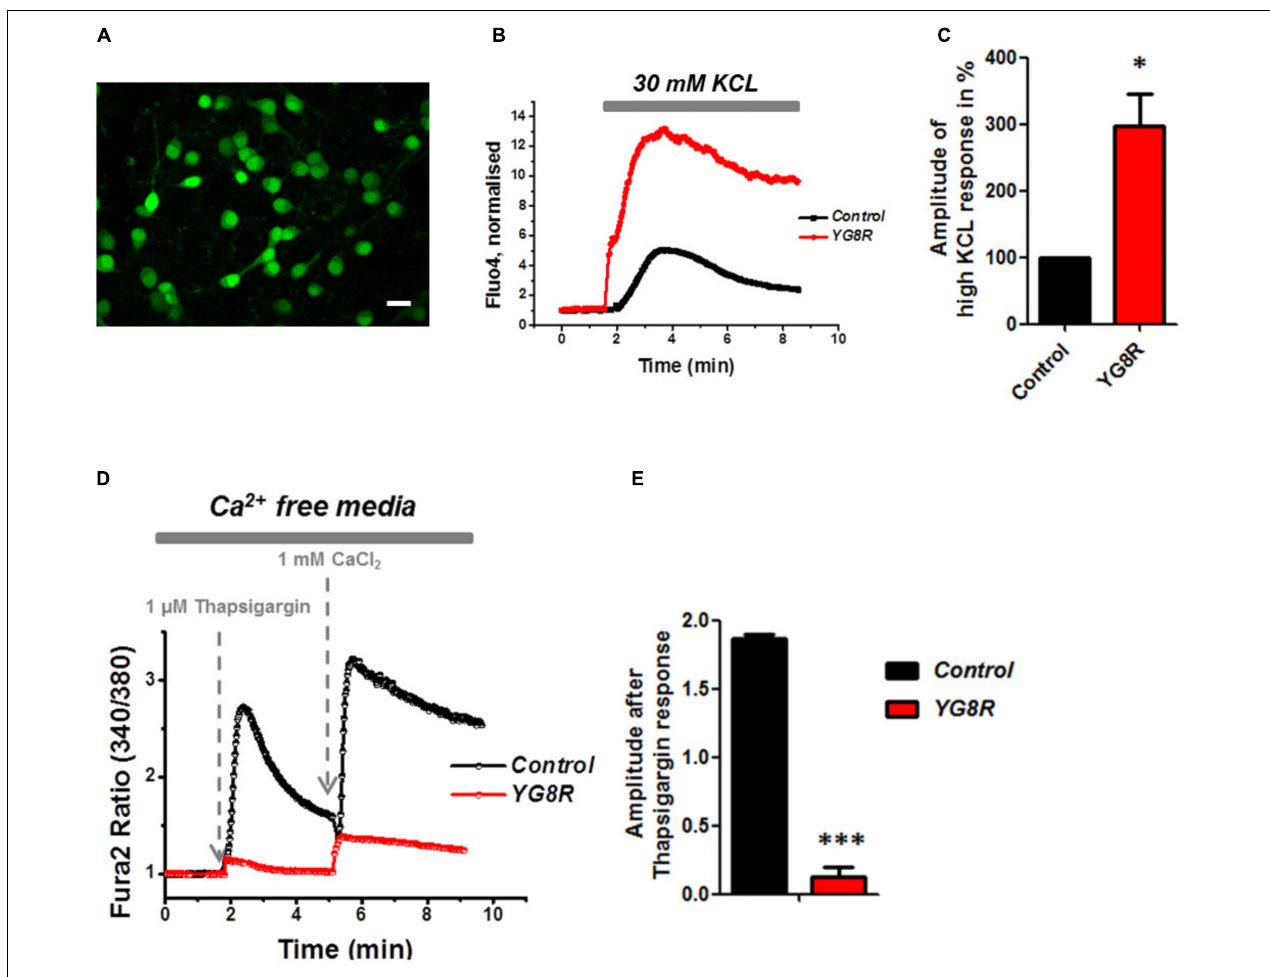
FIGURE 3 | Failure to restore Ca 2 + homeostasis after depolarization in YG8R CGNs. (A–C) CGNs were loaded with Fluo4-AM (A) and challenged with 30 mM KCL (B) , amplitudes were measured and showed a higher response in YG8R than Control ( C ; ∗ p < 0.05). (D,E) CGNs response to 1 µ M Thapsigargin and 1mM CaCl 2 , and relative amplitudes ( ∗∗∗ p < 0.0005). Scale bar (20 µ